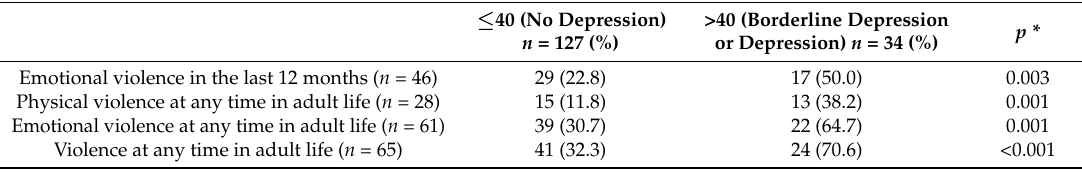
Table 3. Self-rated depression in patients exposed to IPV according to their SDS